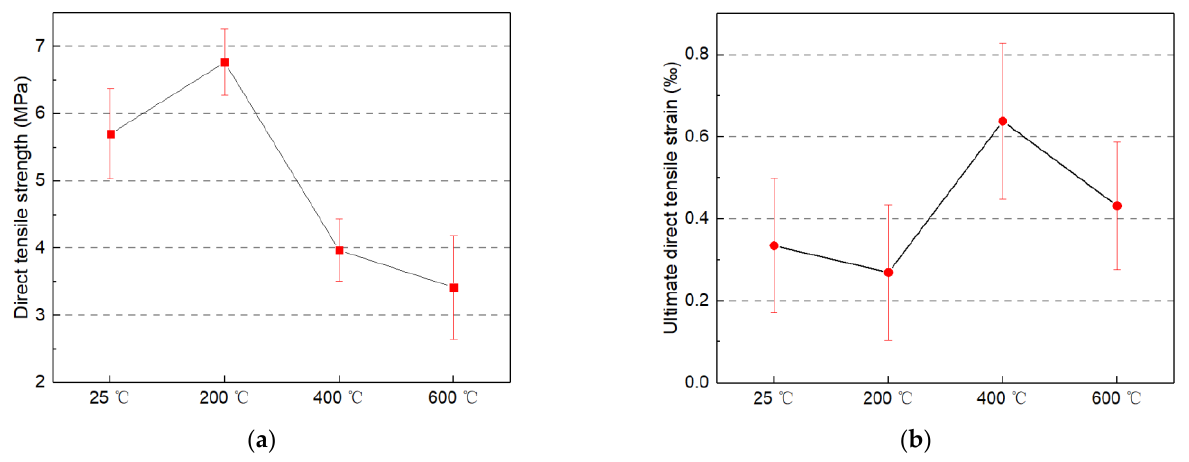
Figure 5. Uniaxial tensile behavior: ( a ) Tensile strength; and ( b ) Tensile strain of heated